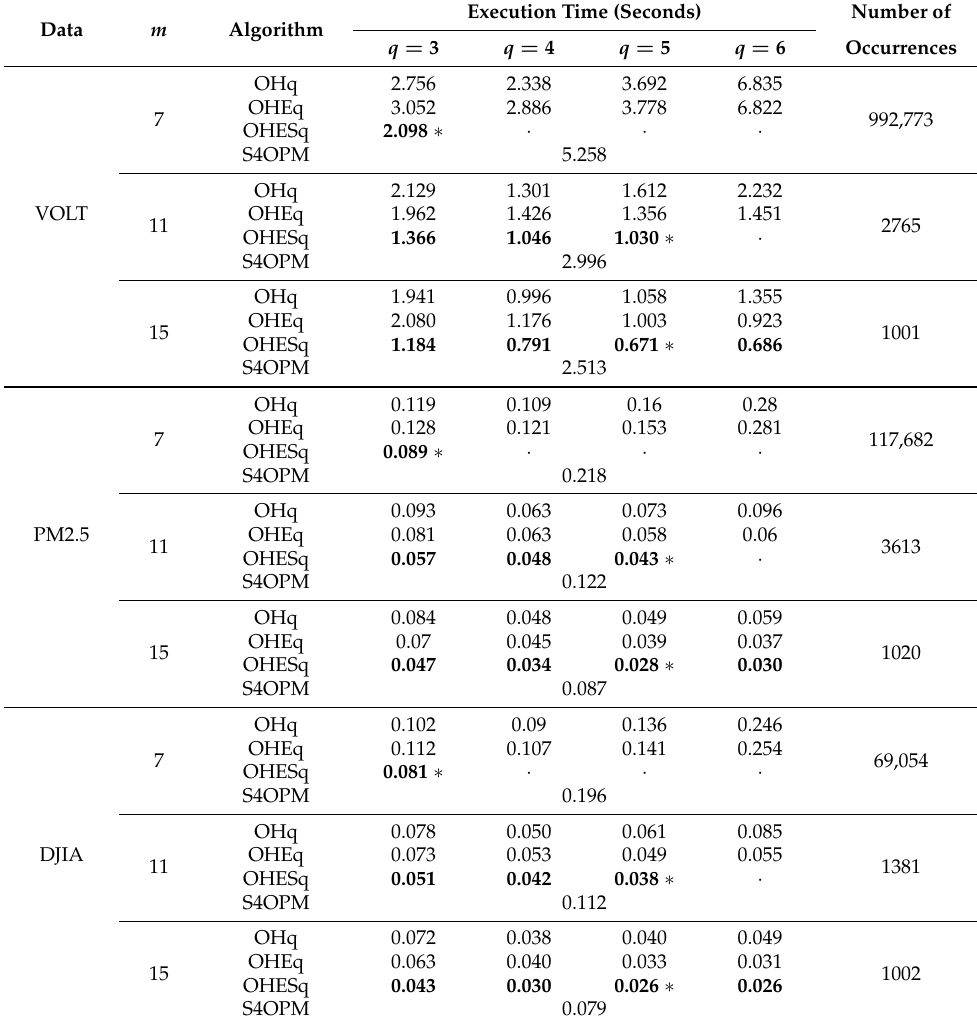
Table 2. Comparison of the execution times and the number of occurrences for VOLT, PM2.5, and DJIA data (sums for 1000 patterns). Bold indicates the execution times of the fastest algorithms for each m and q , and the data marked with ∗ indicate the execution times of the fastest algorithms regardless of q for each m